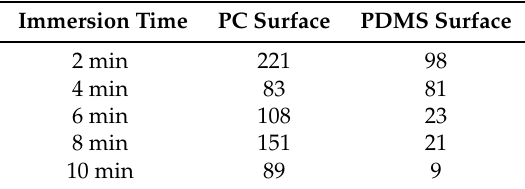
Table 4. The number of fibrils whose height is between 1 and 0.1 µ m.